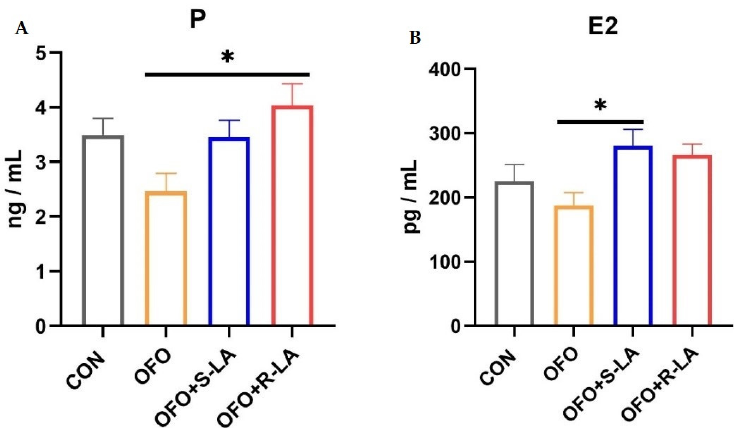
Figure 4. Effect of different treatments on serum estrogen of laying hens. ( A ) Progesterone (P); ( B ) estradiol (E2). * Indicates minimum significant differences ( p < 0.05), and ** indicates highly signifi- cant differences ( p < 0.01).